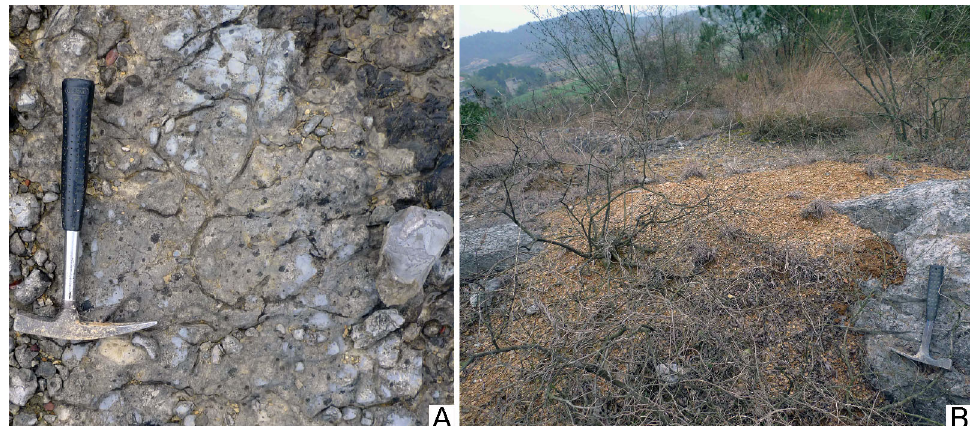
Fig. 2. Outcrop photographs of the top of the second unit in the Xiazhen Formation at Zhuzhai. A , mud cracks implying regression and exposure, hammer length is 28 cm; B , field exposure of the contact between limestones of the second unit and overlying shale beds, hammer length is 28 cm.